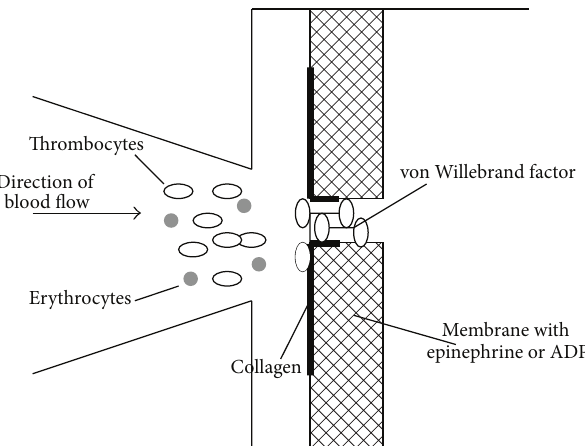
Figure 4: Functional principle of platelet function analysis 100 (PFA100)